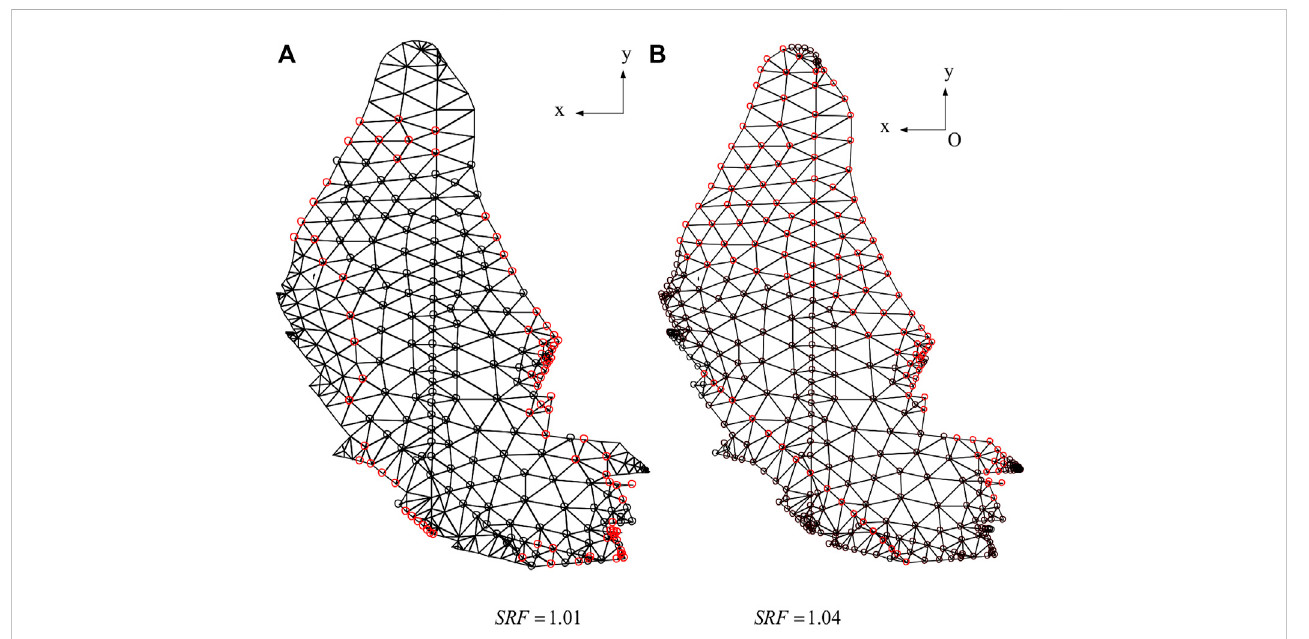
FIGURE 13 Sliding direction vectors of the dam slope at the critical state (A) SRF=1.01 (B)